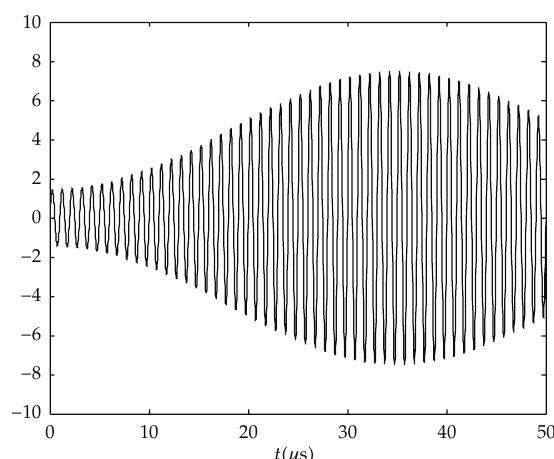
Figure 3: Amplitude-modulated RF carrier in the univariate time.